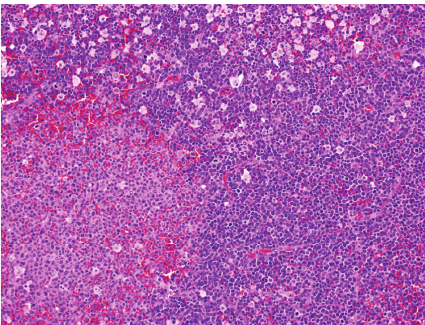
Figure 4: A high power view of darkly staining cellular areas in Figure 1, exhibiting a polymorphous infiltrate, containing cells with large atypical nuclei, with abnormal mitotic figures and scattered apoptotic